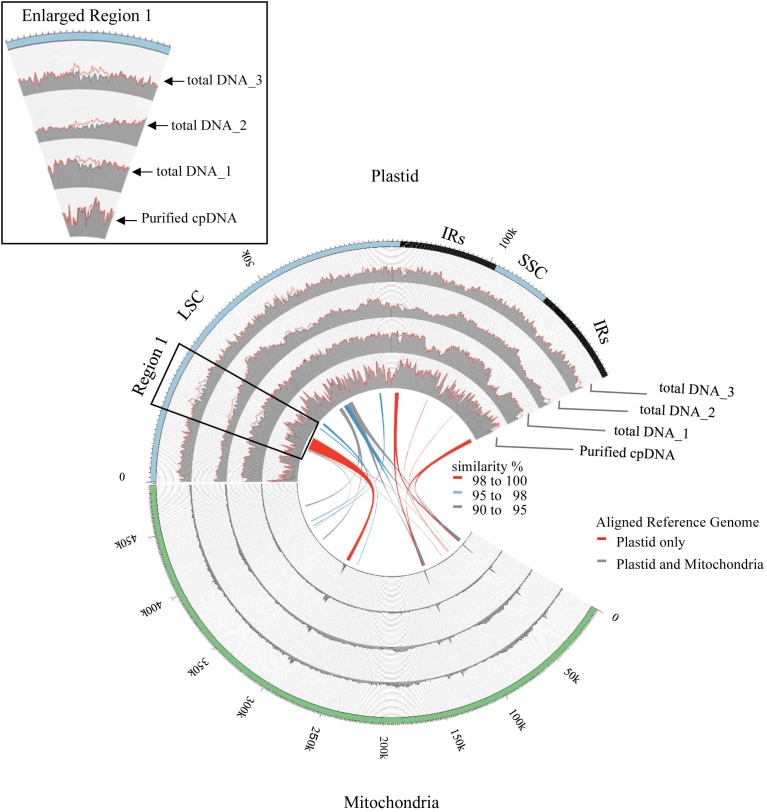
Visualization of read alignment on plastid reference genome. FASTQ reads were aligned on plastid reference genome only (red line) or combined plastid–mitochondrial reference genomes (gray area) followed by visualization of coverage depth in a 250-nt sliding window. Outermost circle shows common plastid genome structures: LSC, large single-copy; SSC, small single-copy; IRs, pair of inverted repeats. Inner colored ribbons mark BLASTN-identified PTMTs; width represents homology; color represents similarity (%).